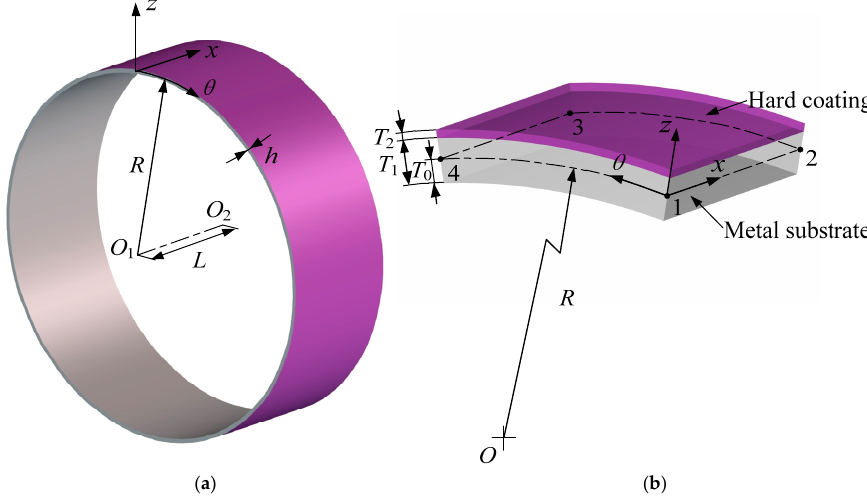
Figure 1. Geometry and element of the hard ‐ coating cylindrical shell. ( a ) Shell geometry; ( b ) Shell element.